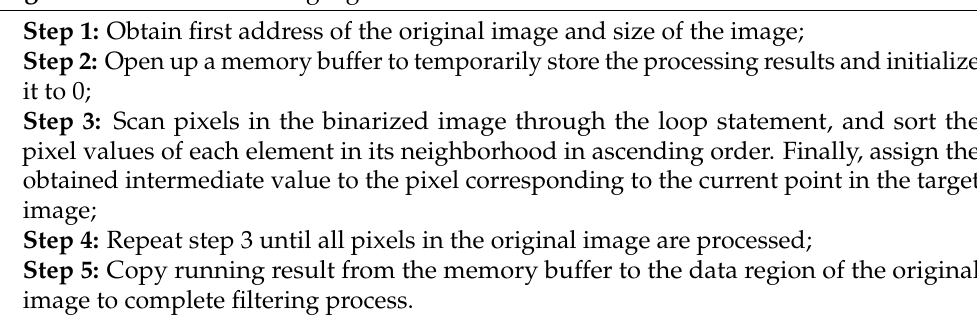
Algorithm 1 Median filtering